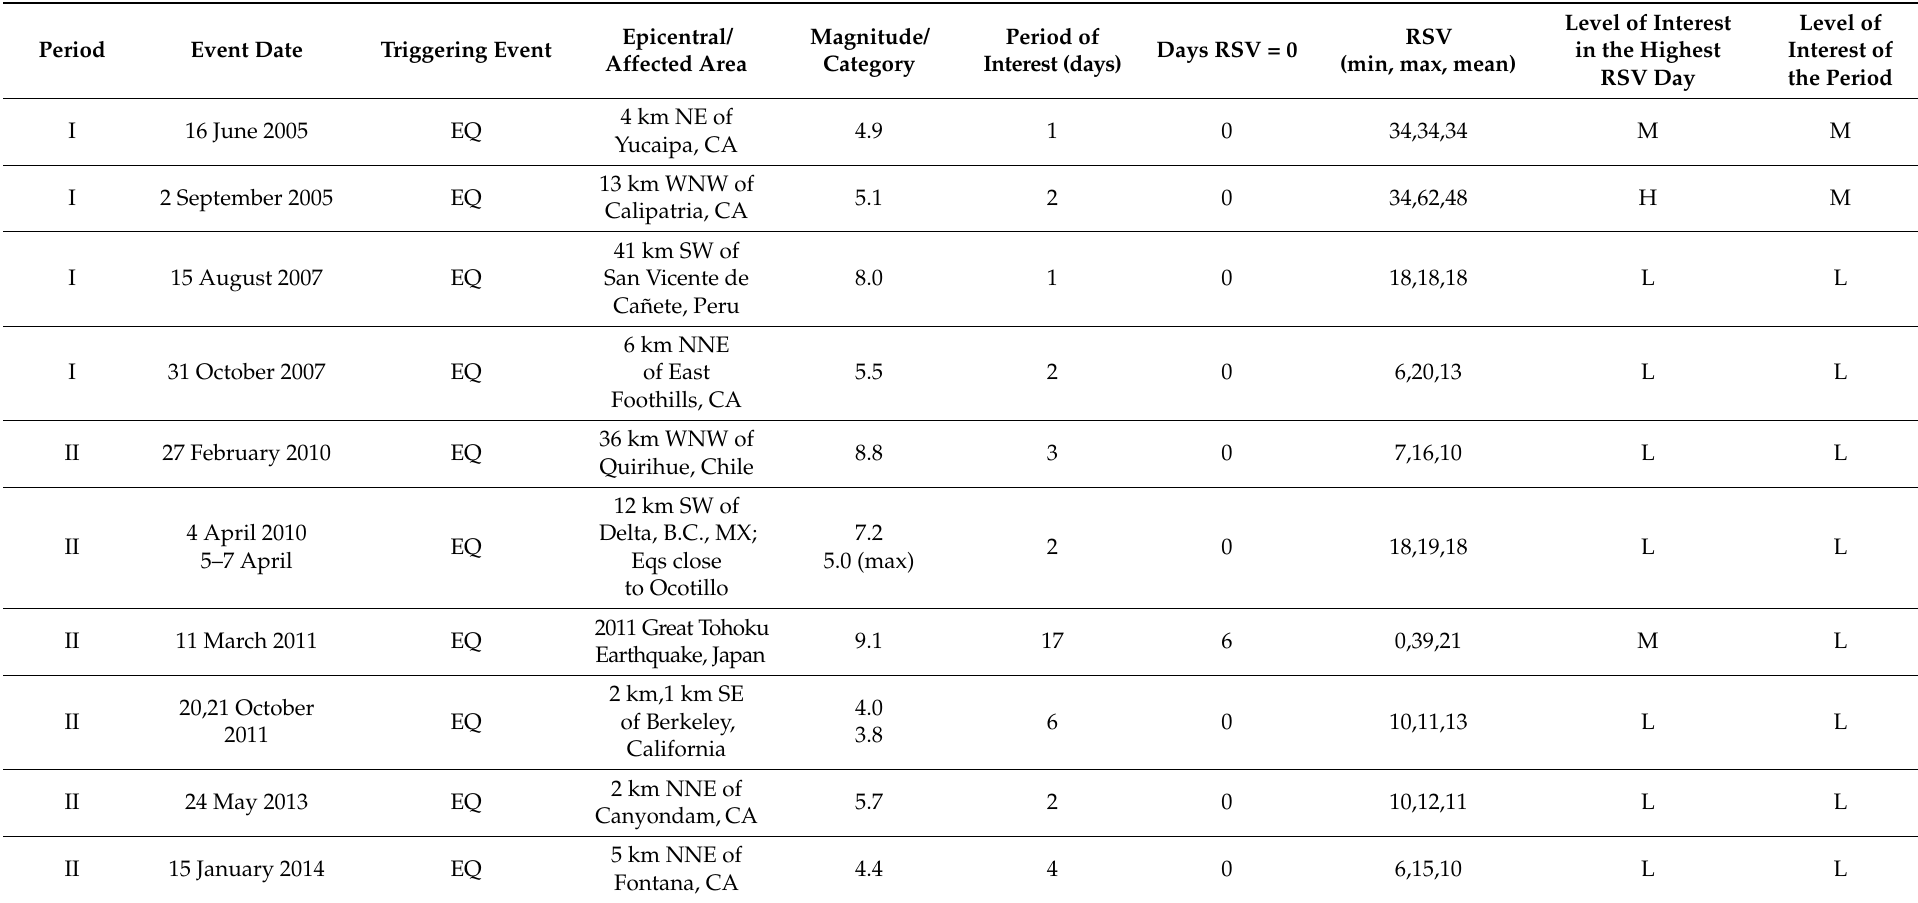
Table 4. Main earthquakes and other natural hazards causing interest rise on earthquake insurance. For each event, the class of interest is attributed both to the day of the highest peak and the whole period in which the increase of RSV was recorded. For the whole periods, the class was attributed considering the mean value of the daily search